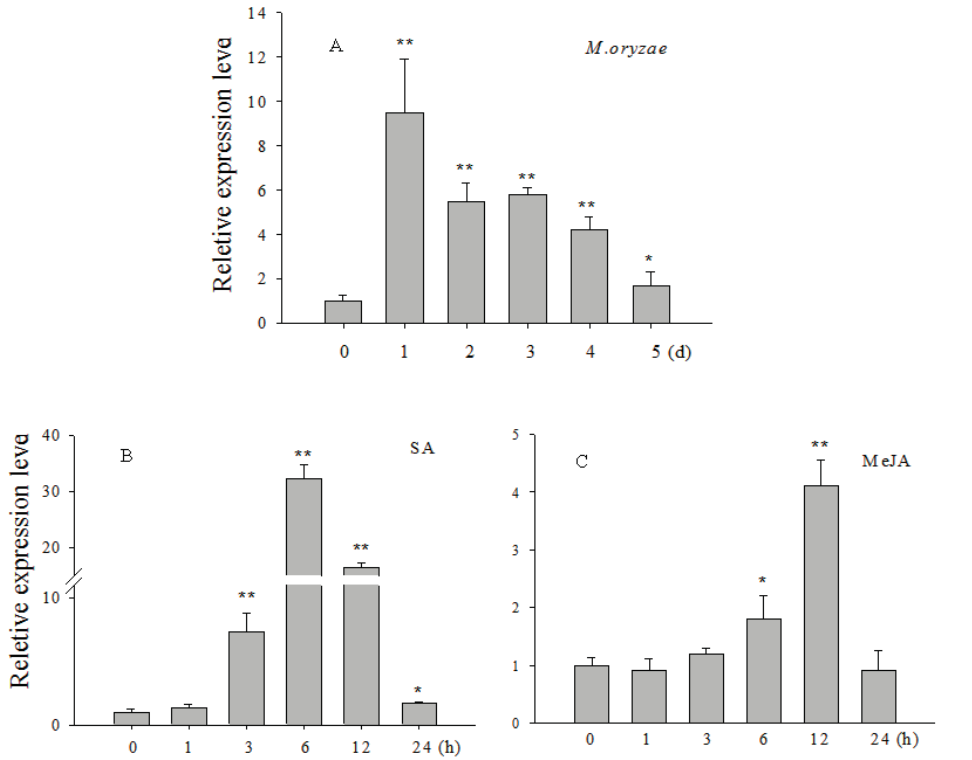
Figure 1. Multiple sequence alignment of the amino acid sequence of OsCBSX3 (cystathionine β -synthase (CBS) domain containing protein 3) and its homolog protein. The CBS domain is underlined predicted by SMART server (http://smart.embl-heidelberg.de/). OsCBSX3 homolog proteins are from Oryza brachyantha ( ObCBSX3 ), Setaria italica ( SiCBSX3 ), Brachypodium distachyon ( BdCBSX3 ) and Zea mays ( ZmCBSX3 ). Sequeneces identical or similar are highlighted in black and red,